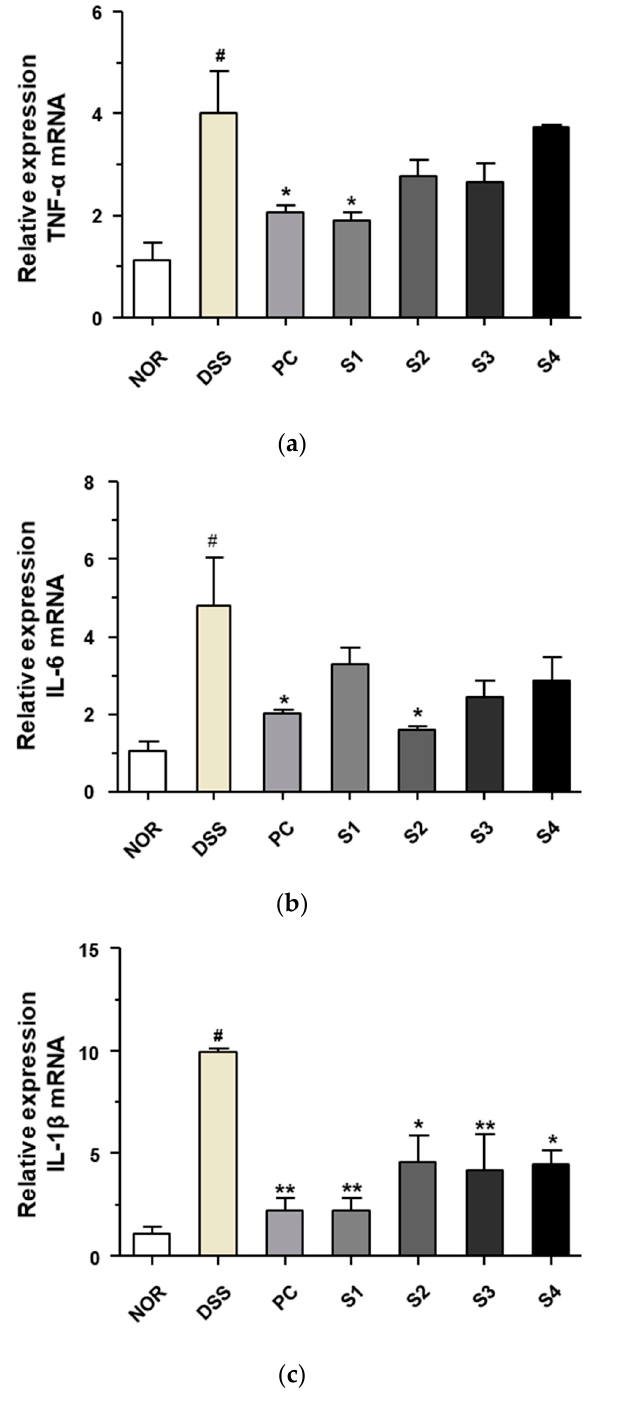
Figure 4. Inhibitory effect of Cheonggukjang on the mRNA and protein secretion of proinflammatory cytokines in DSS-induced colitis mice: mRNA levels of ( a ) TNF- α , ( b ) IL-6 , and ( c ) IL-1 β in colonic tissues; Protein levels of ( d ) TNF- α , ( e ) IL-6 , and ( f ) IL-1 β in the serum. Values are presented as the mean ± SD (n = 5); #, p < 0.005 versus normal group; ***, p < 0.001; **, p < 0.005; *, p < 0.05 versus DSS group.